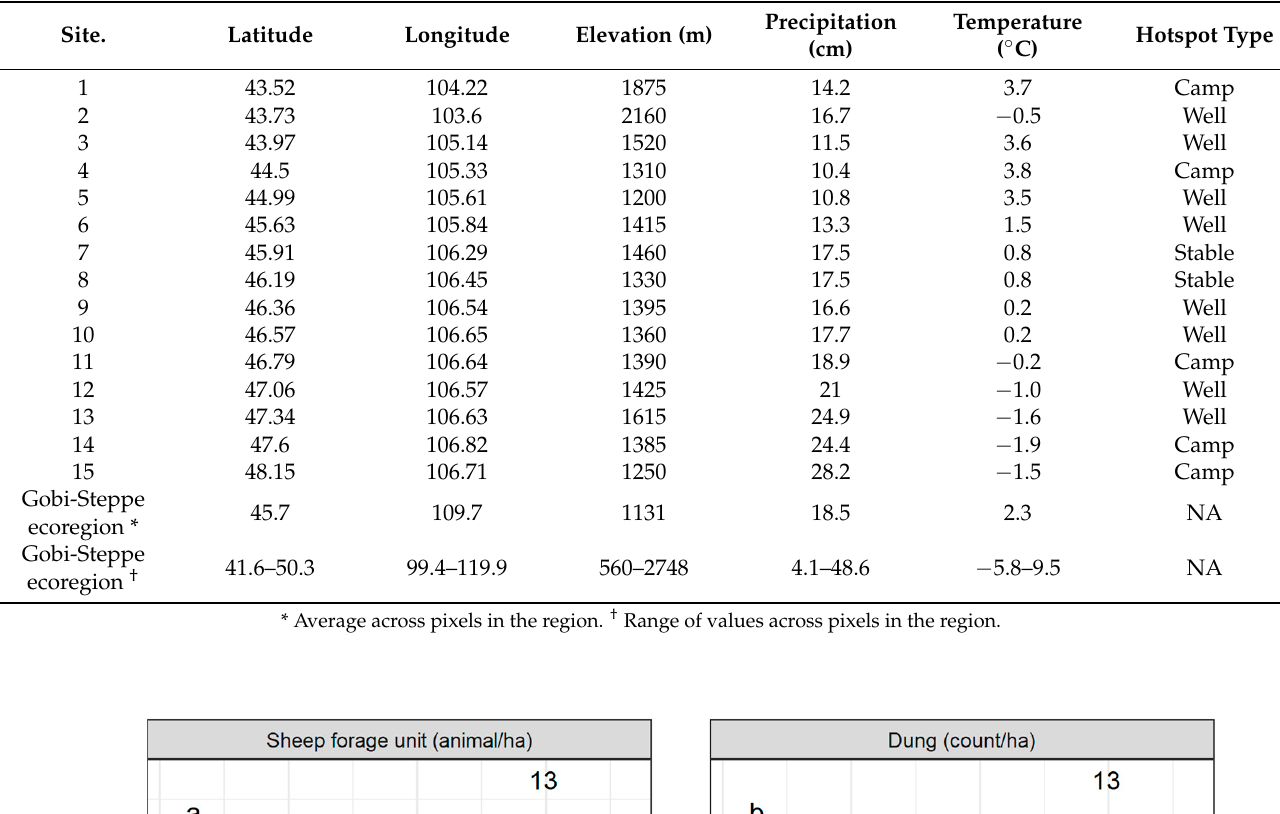
Table A1. Site information for simulated sites. RPM was run at 15 sites numbered from south to north, where biomass and animal dung were sampled at distance transects from grazing hotspots. A gridded simulation was run in RPM covering the Gobi-Steppe ecoregion, a 64 million ha region covering the eastern portion of Mongolia. See Figure 1 in main text for site locations. Mean annual precipitation and temperature from Worldclim v2.0.